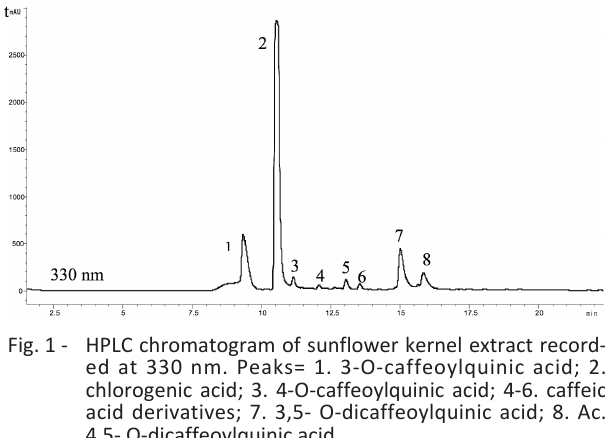
Fig. 1 - HPLC chromatogram of sunflower kernel extract record- ed at 330 nm. Peaks= 1. 3-O-caffeoylquinic acid; 2. chlorogenic acid; 3. 4-O-caffeoylquinic acid; 4-6. caffeic acid derivatives; 7. 3,5- O-dicaffeoylquinic acid; 8. Ac. 4,5- O-dicaffeoylquinic